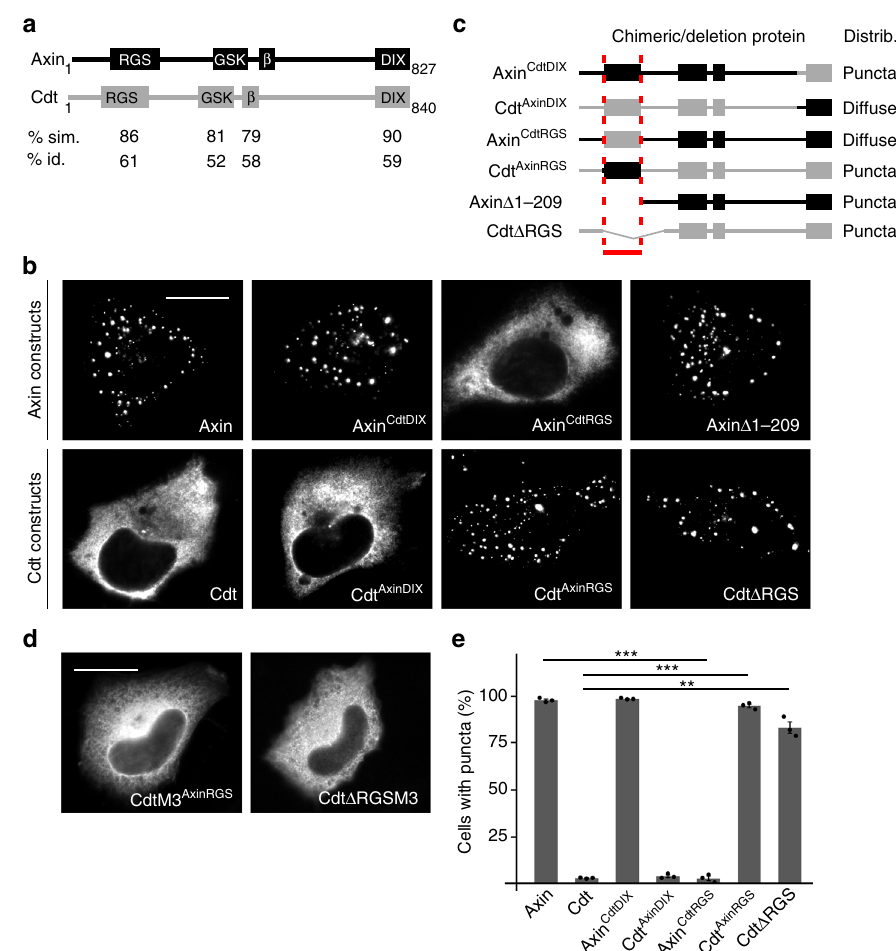
Fig. 1 The conductin RGS domain prevents DIX-mediated polymerization. a Schematic to scale representation of axin and conductin (Cdt) with the domains interacting with APC (RGS), GSK3 (GSK), and β -catenin ( β ), and the polymerization domain (DIX). Percentage similarity (sim.) and identity (id.) are shown for each domain. b , d GFP fl uorescence in U2OS cells transfected with indicated GFP-tagged axin or conductin constructs. Scale bars: 20 µ m. c Schematic representation of chimeric axin-conductin proteins with axin parts shown in black and conductin parts in gray, and deletion mutants of axin and conductin used in b ; not to scale. Distribution (Distrib.) is indicated on the right. Red lines mark the protein part (RGS domain) which determines distribution. e Percentage of transfected cells showing puncta formation of indicated constructs. Per construct, 1500 cells of three independent experiments as in b were analyzed. Results are mean ± SEM ( n = 3). ** p < 0.01, *** p < 0.001 (Student ’ s t -test). Source data are provided as a Source Data fi